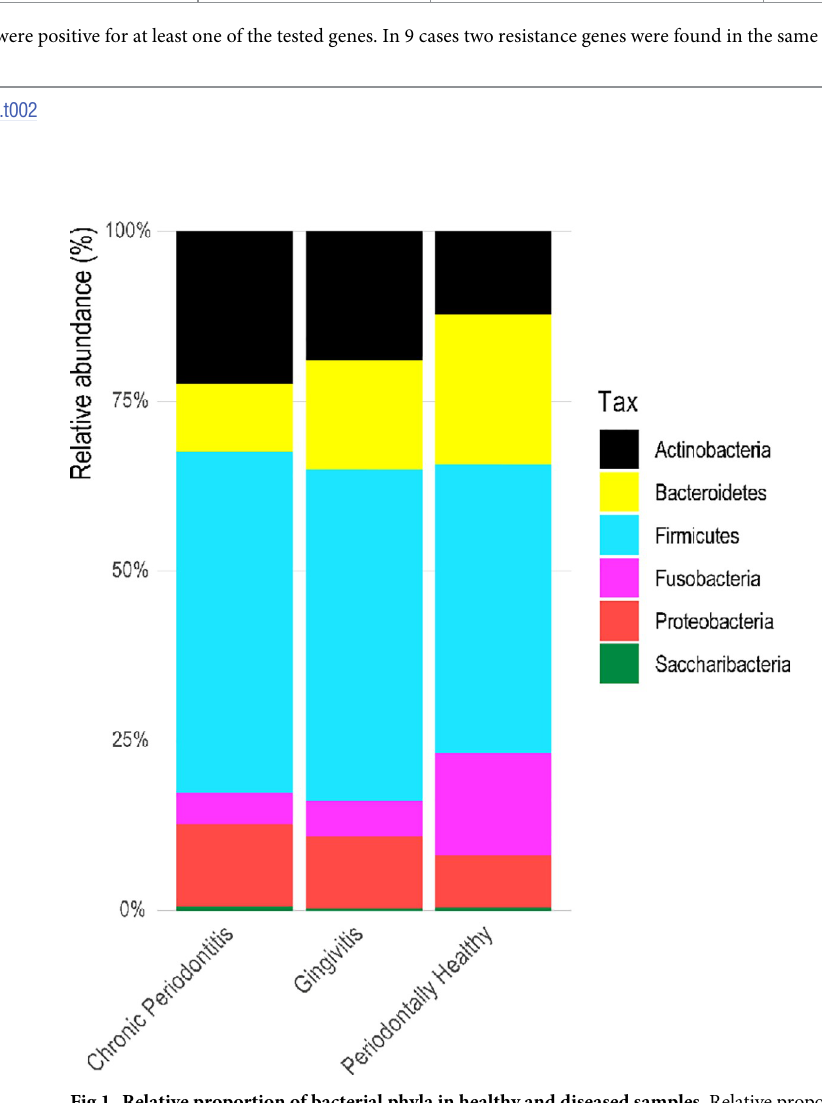
Of the 110 samples recovered, 80 (72.7%) were positive for at least one of the tested genes. In 9 cases two resistance genes were found in the same sample. Overall, 89 ARGs were detect.